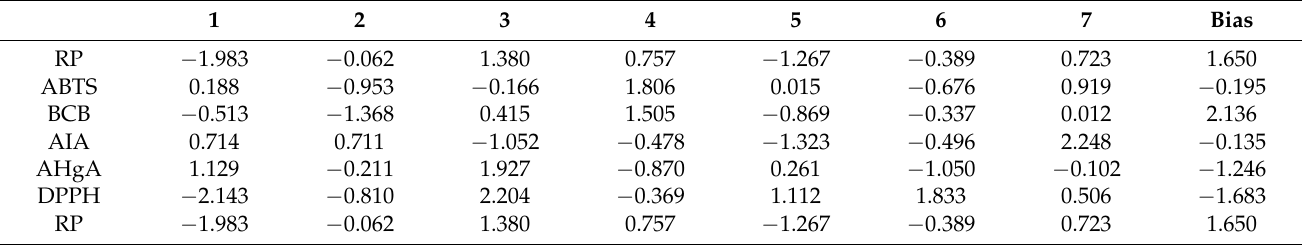
Table A2. Elements of matrix W 2 and vector B 2